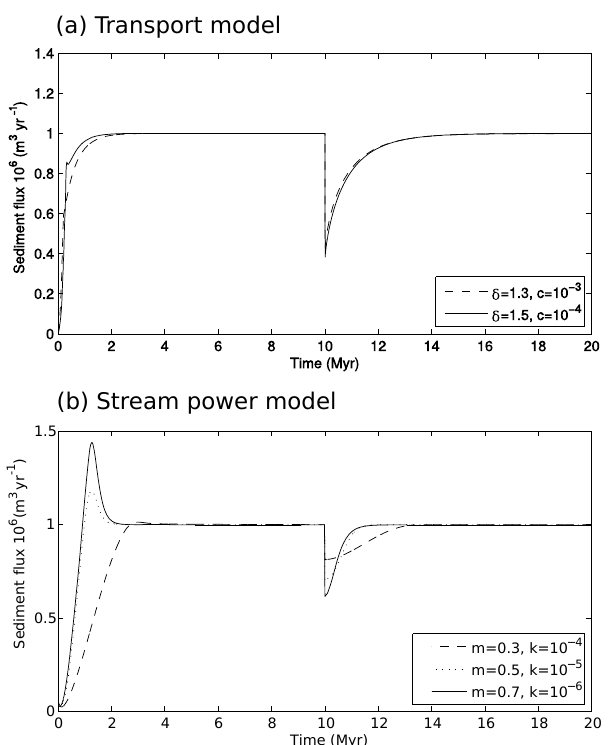
Figure 6. Response of the transport and stream power model to a reduction in precipitation rate. (a) Sediment flux for the transport model for a step reduction in precipitation from 1 to 0.5myr − 1 after 10Myr. Two models are plotted in which δ = 1 . 3 and 1.5, κ = 10 − 2 , and c = 10 − 3 and 10 − 4 (m 2 yr − 1 ) 1 − δ . (b) Sediment flux for the stream power model for a step reduction in precipita- tion from α 0 = 1 to α 1 = 0 . 5myr − 1 after 10Myr. Three models are plotted in which m = 0 . 3, 0.5, and 0.7 and k = 10 − 4 , 10 − 5 , and 10 − 6 m − 1 (m 2 yr − 1 ) 1 − m .